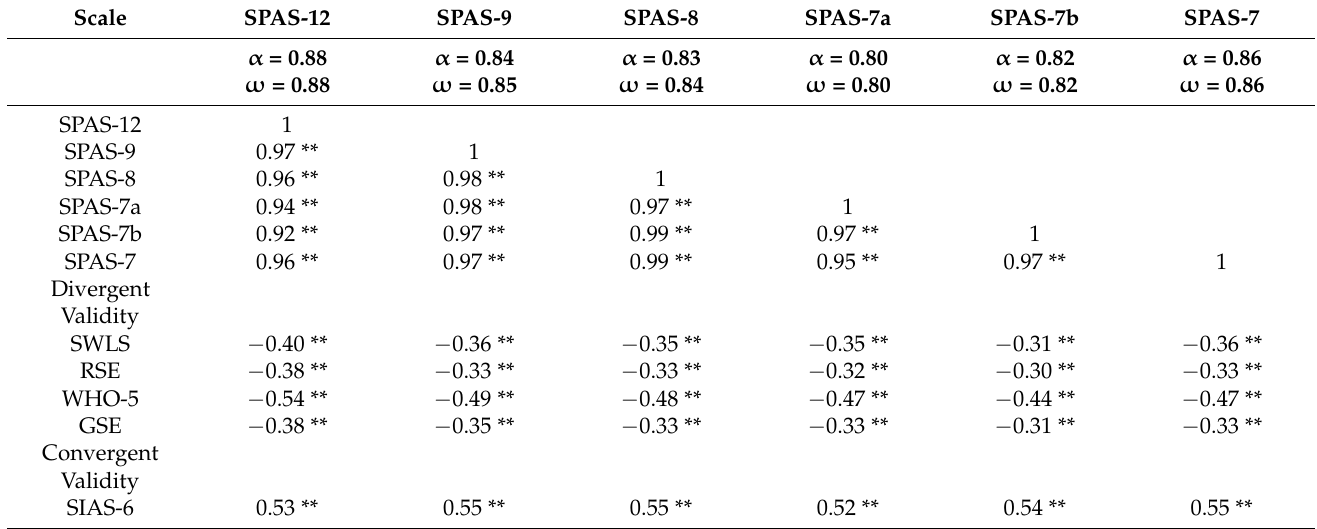
Table 5. Correlation for six SPAS models in relation to construct-related scales in Study